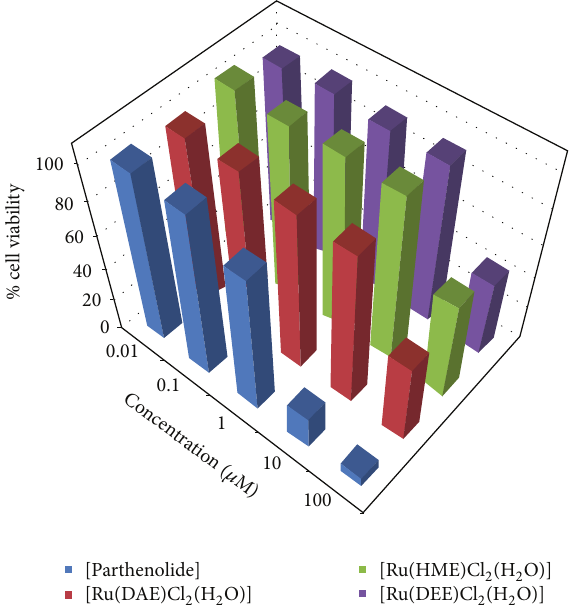
Figure 3: In vitro antiproliferative activity of Ru(III) complexes and parthenolide against human melanoma cancer cell